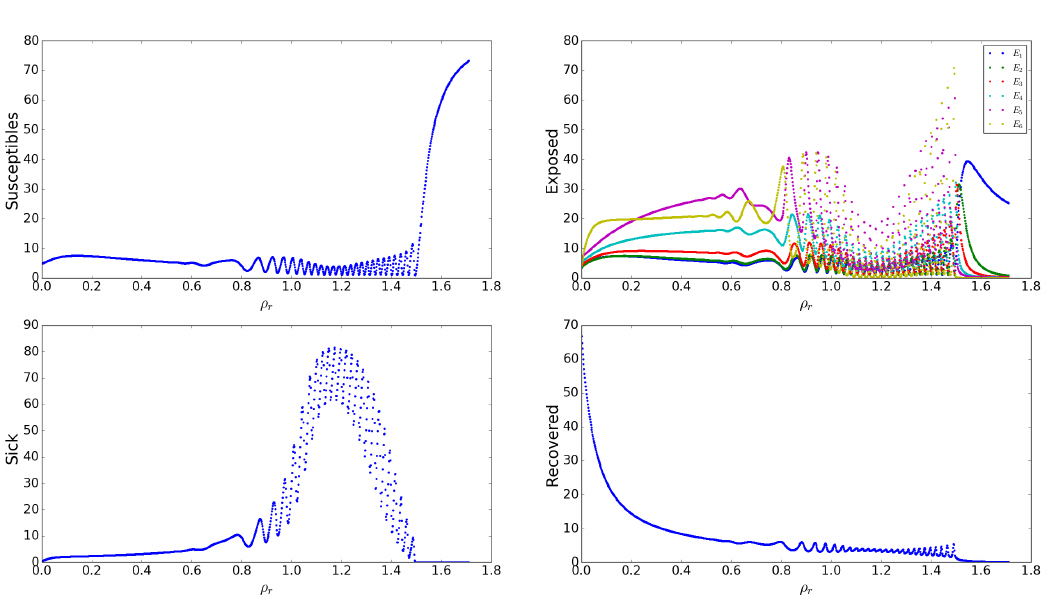
Figure A3. Behaviors of infectious classes relative to the ρ E The horizontal axes scale the parameters ρ r and the vertical axes represent human populations. The profiles for the variables depict an endemic stationary branch followed by a chaotic behavior, then another stationary branch where the disease is